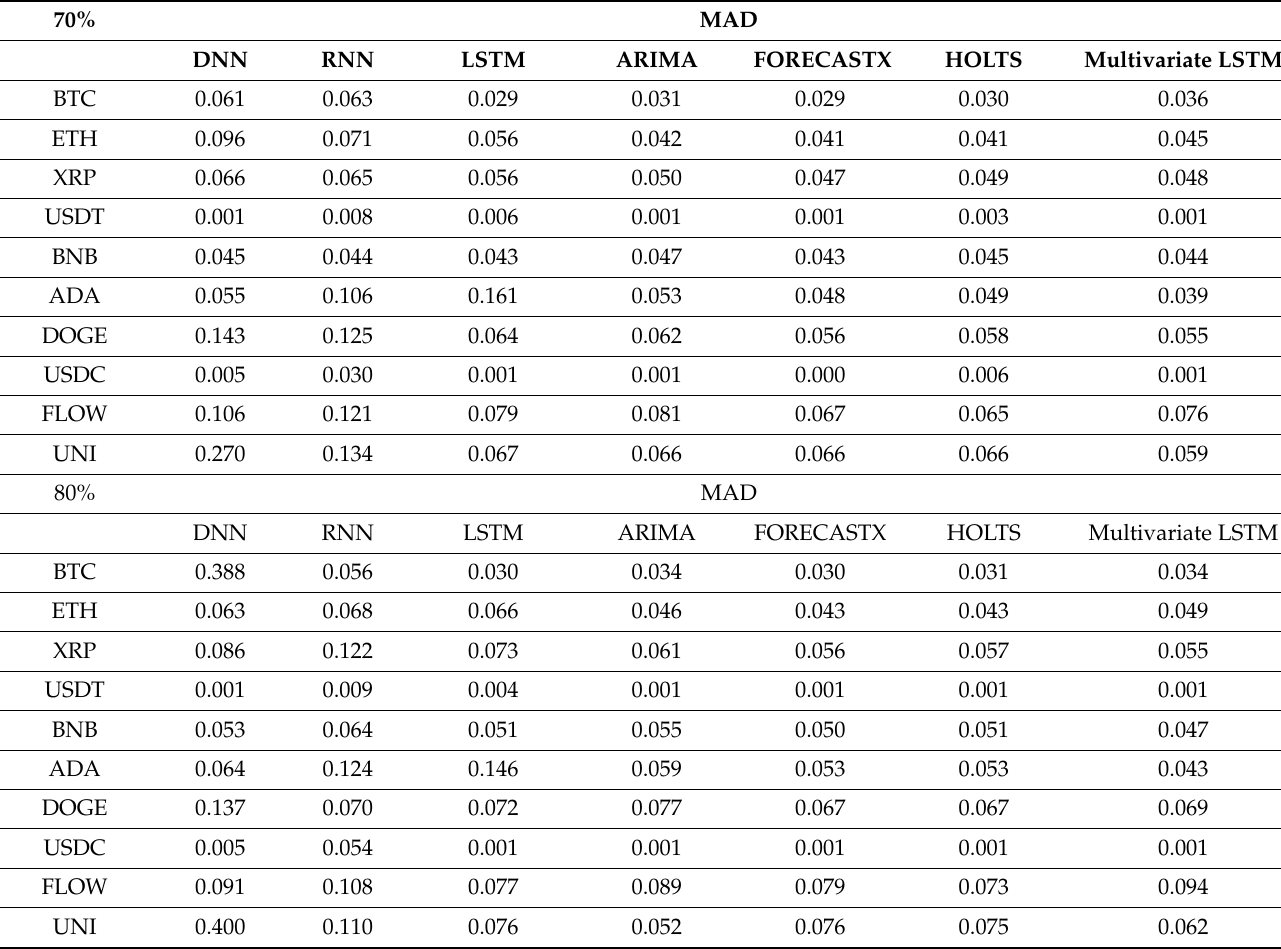
Table 3. Measuring predictions using